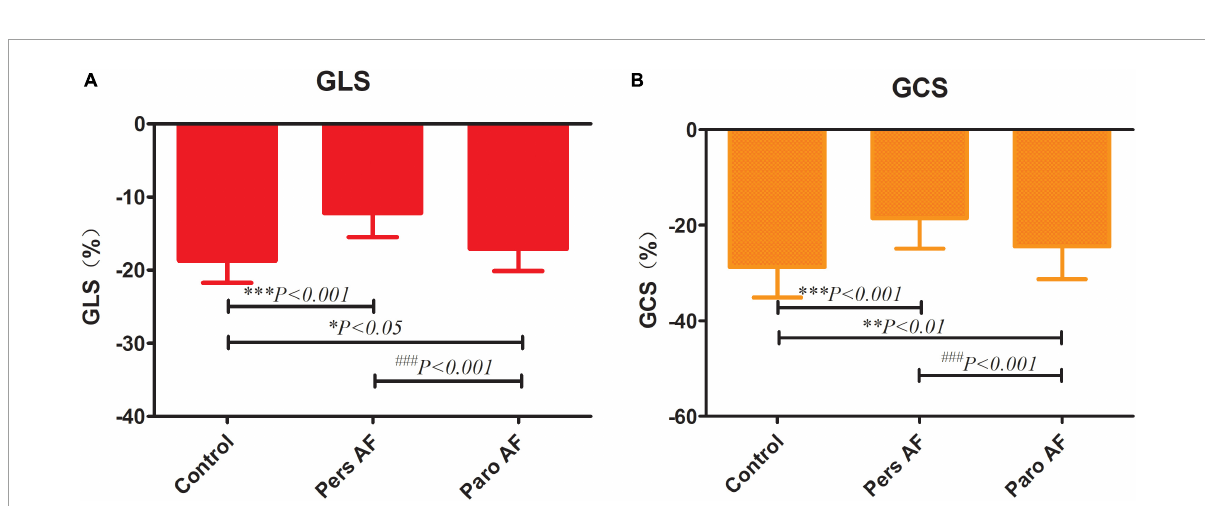
FIGURE4 Comparison of GLS (A) and GCS (B) among control subjects and subjects with different types of AF. GLS, global longitudinal strain; GCS, global circumferential strain; GLS ( − 18.71 ± 3.00% in controls, − 17.10 ± 3.01% in Paro AF, − 12.23 ± 3.25% in Pers AF) GCS ( − 28.75 ± 6.34% in controls, − 24.43 ± 6.86% in paroxysmal AF, − 18.46 ± 6.42% in persistent AF) vs. control, ∗ P < 0.05, ∗∗ P < 0.01, ∗∗∗ P < 0.001; vs. pers AF, ### P <